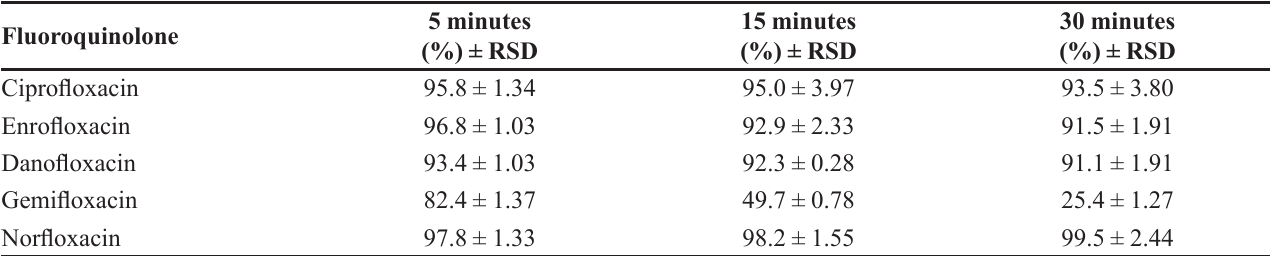
Media ± standard deviation are expressed in percentage. RSD, relative standard